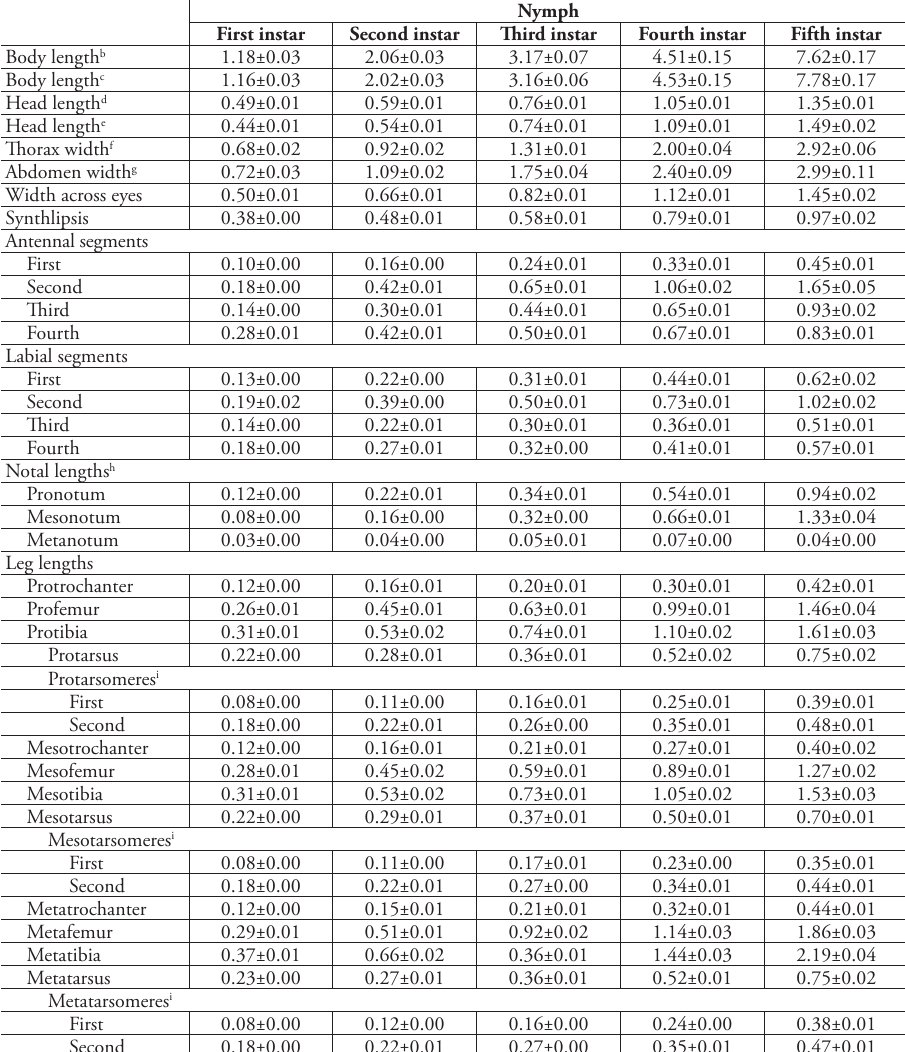
Measured from apex of tylus to apex of abdomen with head in normal declivent position. c Measured from apex to juga (often exceeding tylus) to apex of abdomen with head in normal declivent position. d Measured from apex of tylus to apex of head in horizontal position. e Measured from apex of juga to apex of head in horizontal position. f Measured across mesonotum. gf Measured across abdominal segments 3–4 . h Measured across midline. i Total length of measured segments > overall length because of